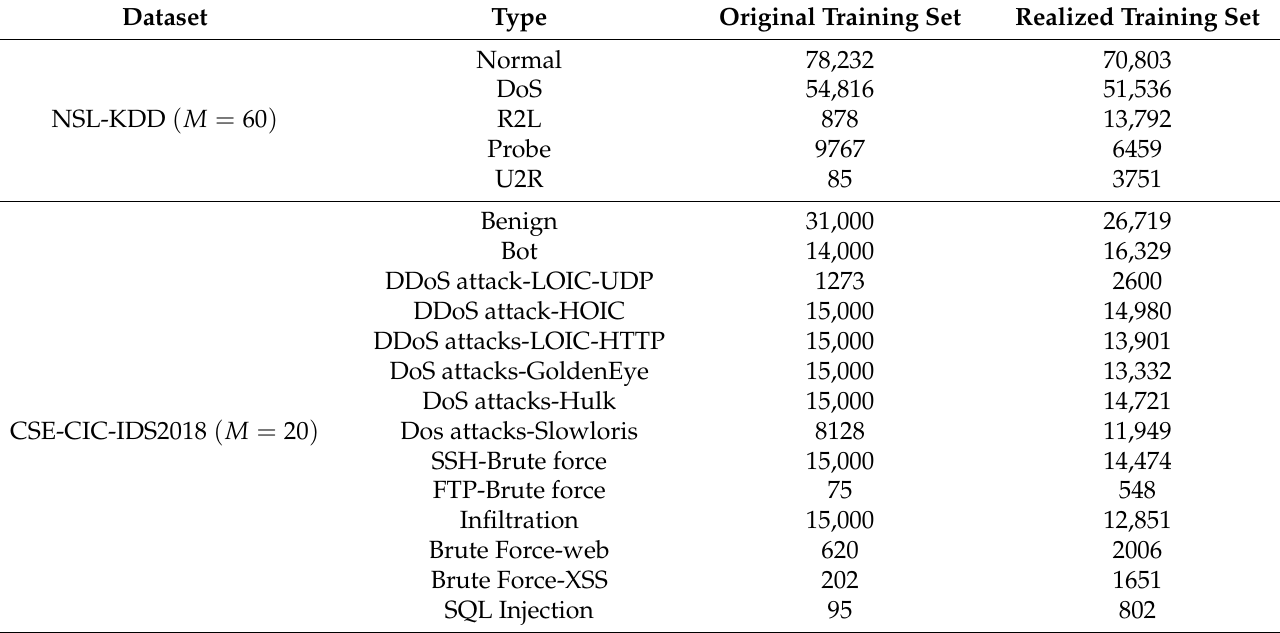
Table 9. The newly generated training set class distribution treated by the proposed genetic